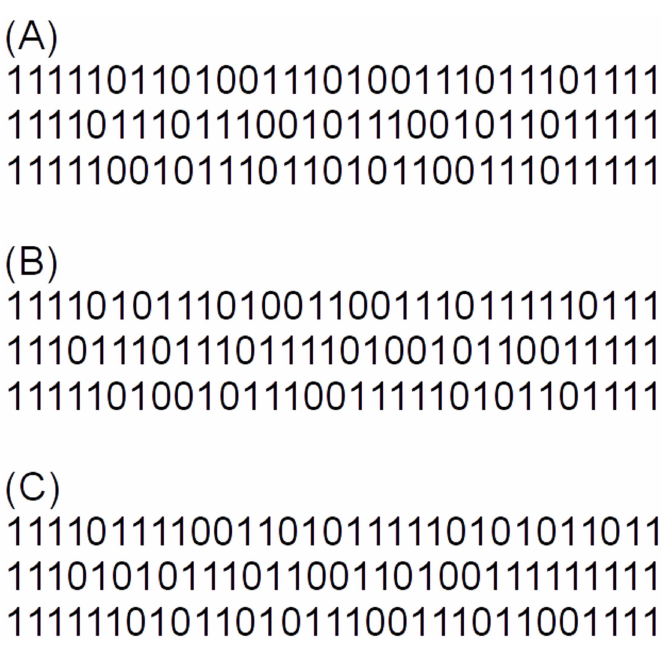
Fig 3. Pattern sets for short read classification. Pattern sets used for short read classification: (A) as used by default in CLARK-S , (B) generated with rasbhari minimizing overlap complexity and (C) generated with rasbhari maximizing sensitivity .